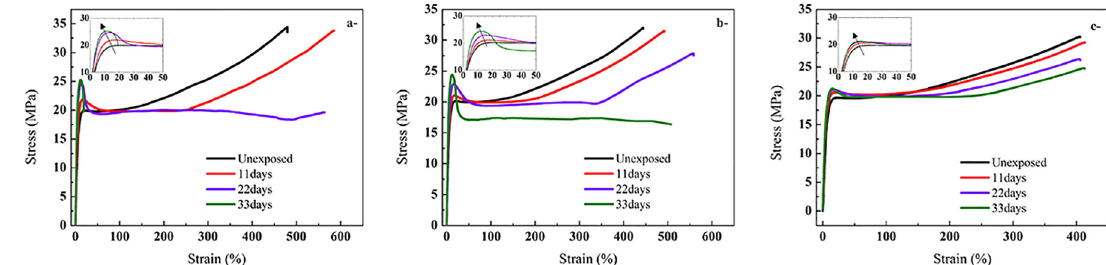
Figure 7. Representative stress strain curves of UHMWPE exposed for various times : (a) neat; (b) UHMWPE with 1% of iron ore fine; (c) UHMWPE with 10% of iron ore fine. Inset shows a magnification of the yielding